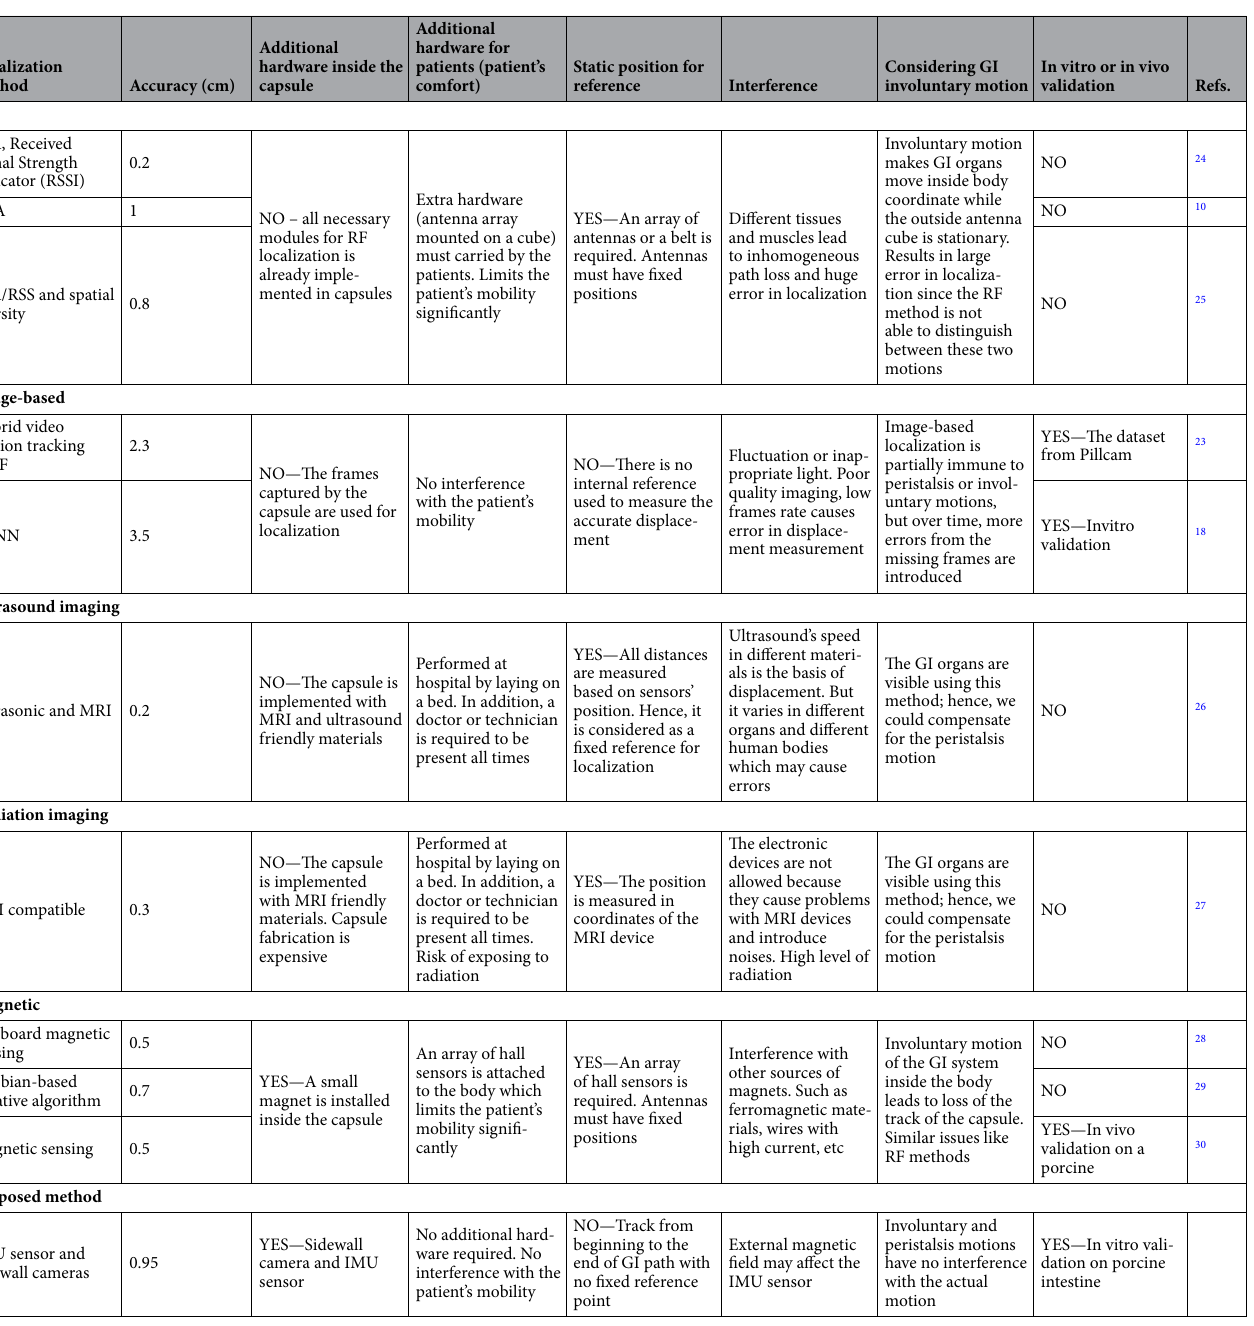
Table 2. Comparing available WCE localization